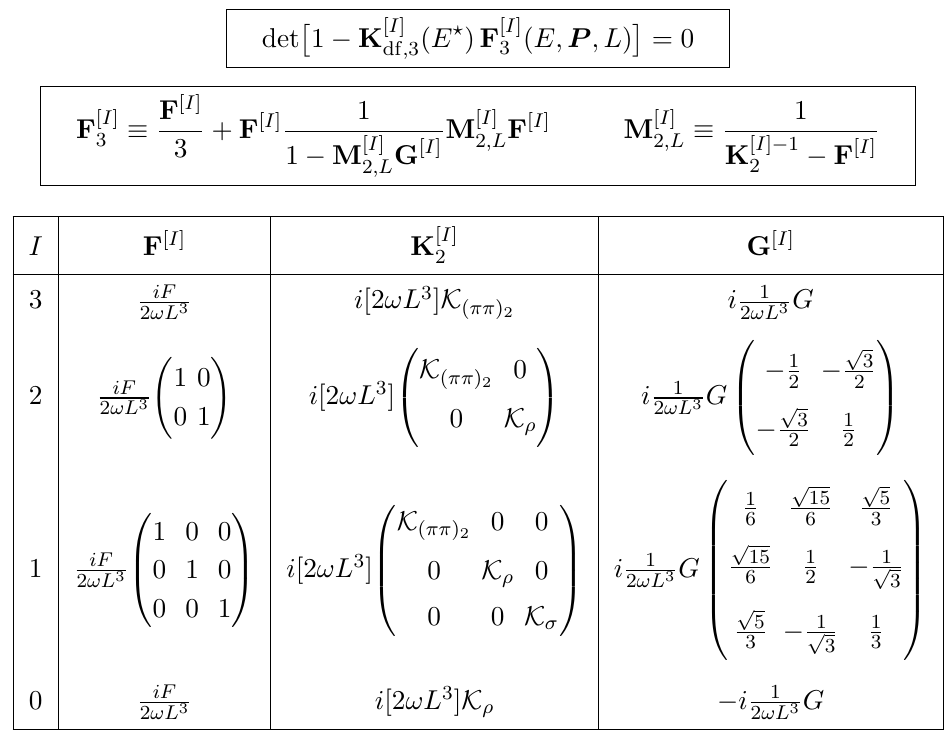
Table 1 . Summary of quantization conditions for all allowed values of the total isospin I = I (cid:25)(cid:25)(cid:25)